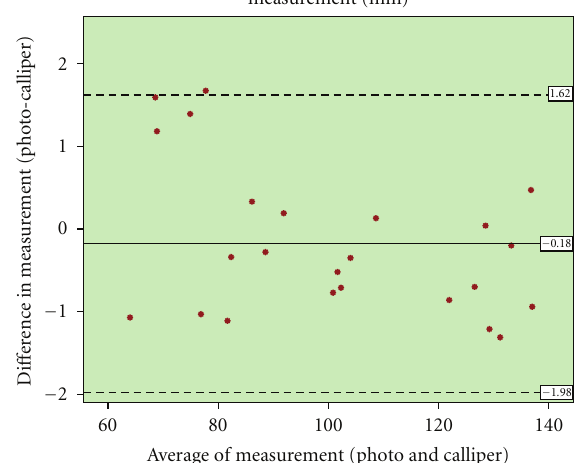
Figure 6: Bland and Altman plot for the diameter measurement comparison of vernier calliper and